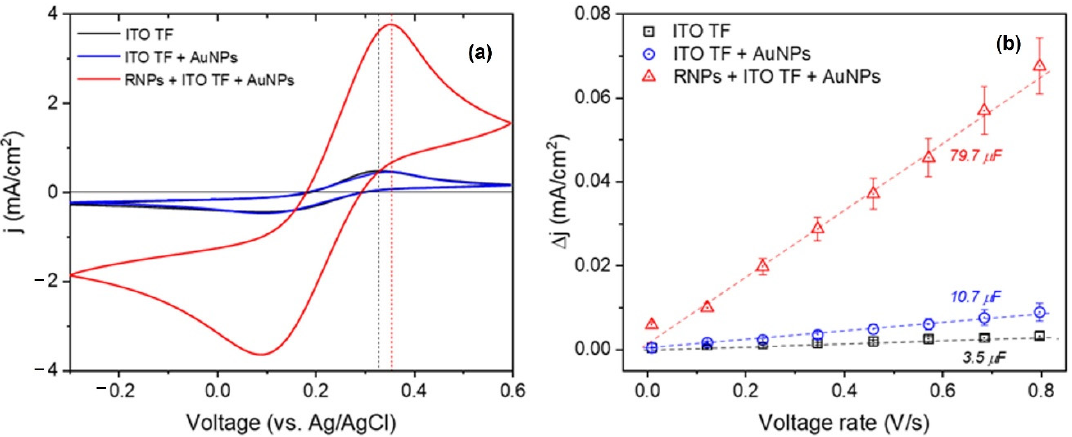
Figure 4. Electrochemical characterization of ITO/Au thin films. ( a ) Cyclic voltammograms in a ferri/ferrocyanide electrolyte recorded at a scan rate of 50 mV s − 1 for the indicated samples. ( b ) Plot of the density currents determined from ECSA cyclic voltammograms as a function of scan rate (data corresponding to a phosphate solution).